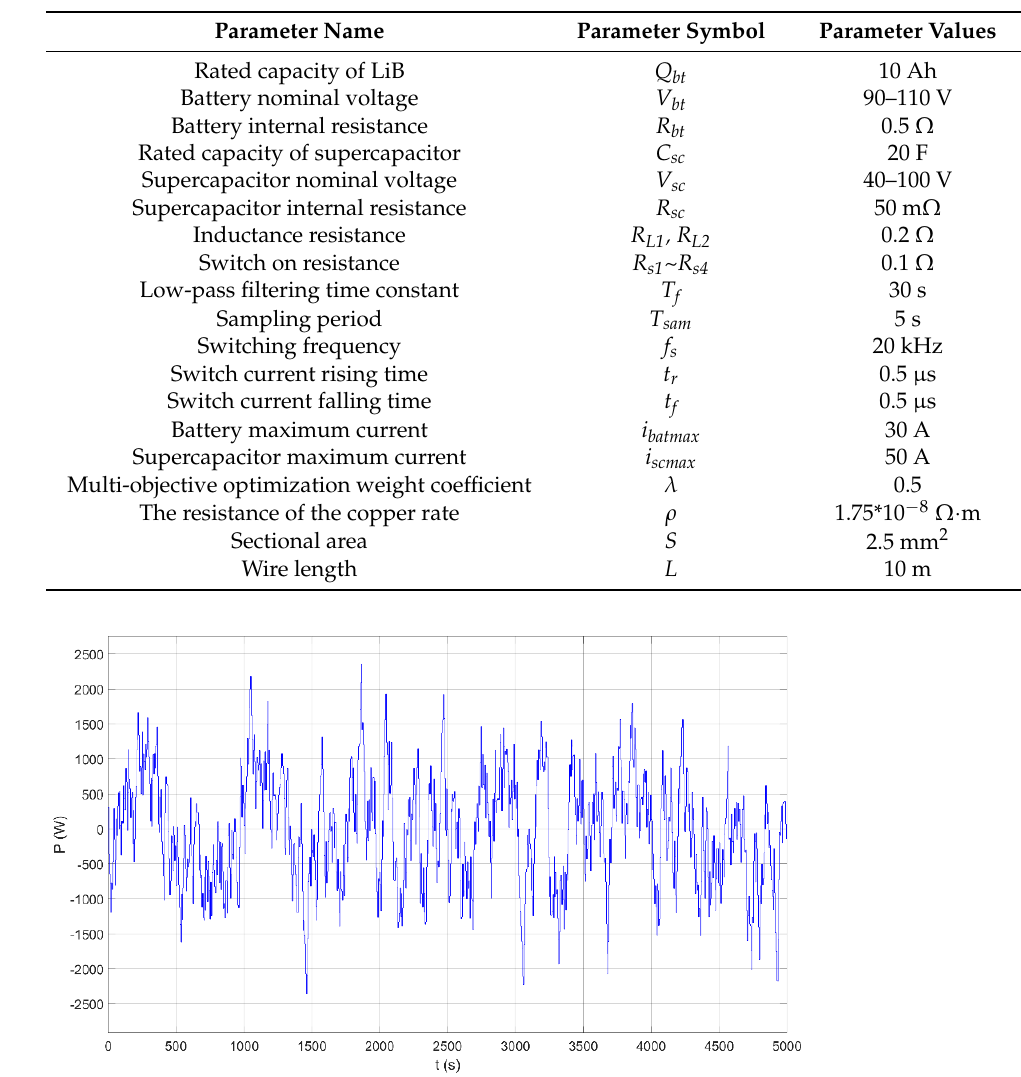
Figure 12. The testing power profile.